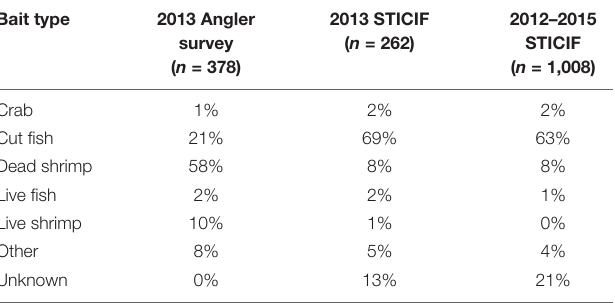
TABLE 2 | Bait type used by recreational anglers during the 2013 Angler Survey and 2012–2015 sea turtle incidental captures. Bait